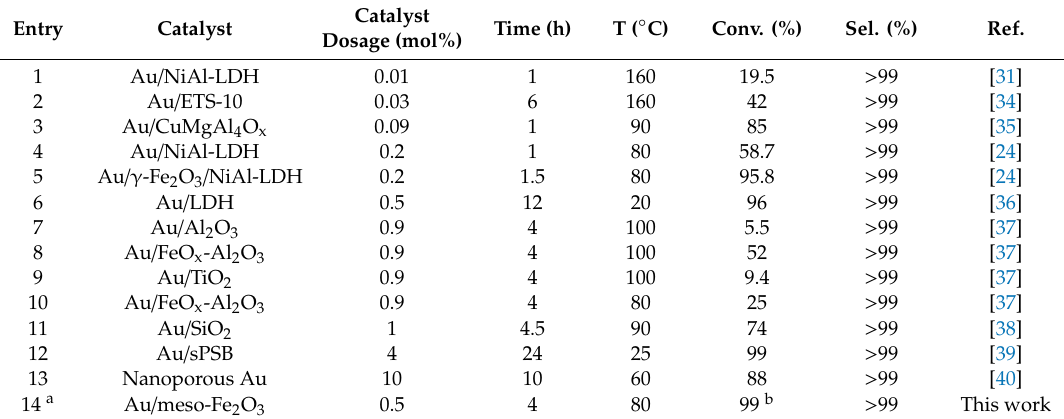
Table 4. Aerobic oxidation of 1-phenylethanol over various Au catalysts.